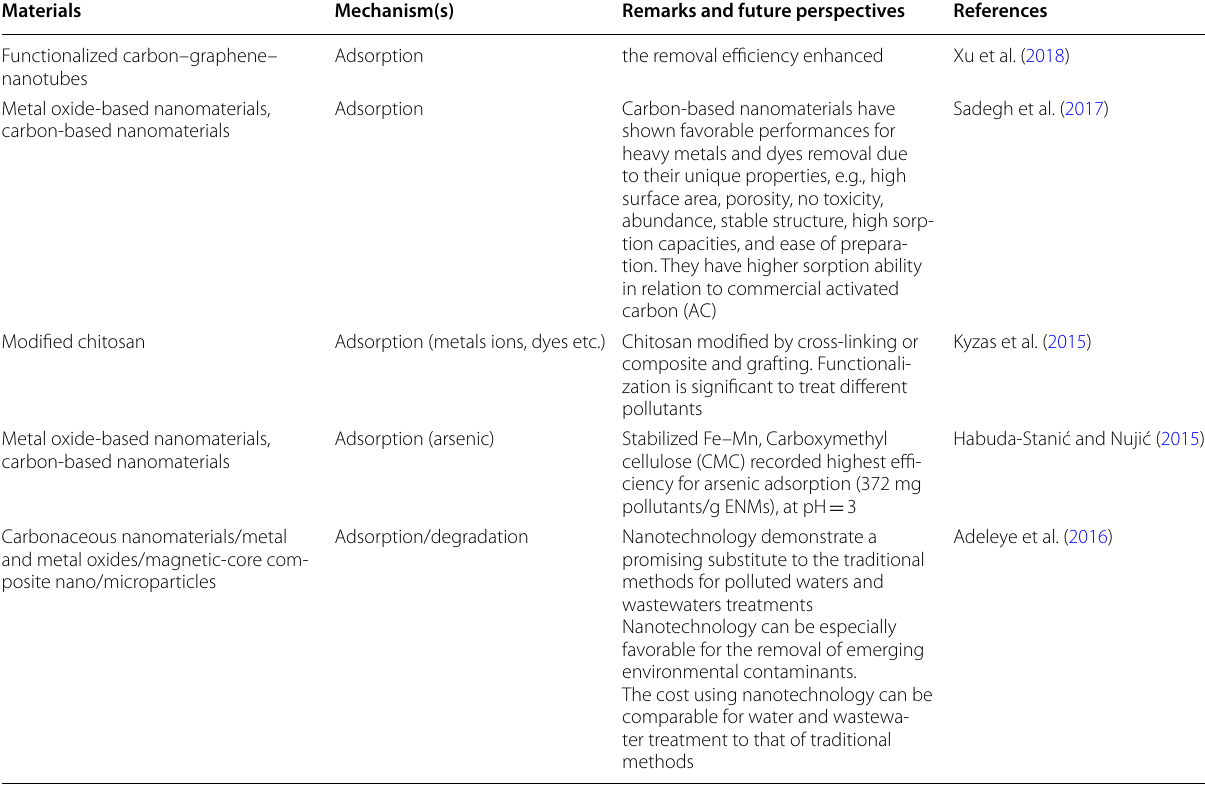
Table 4 Application of nanomaterials for water and wastewater treatment